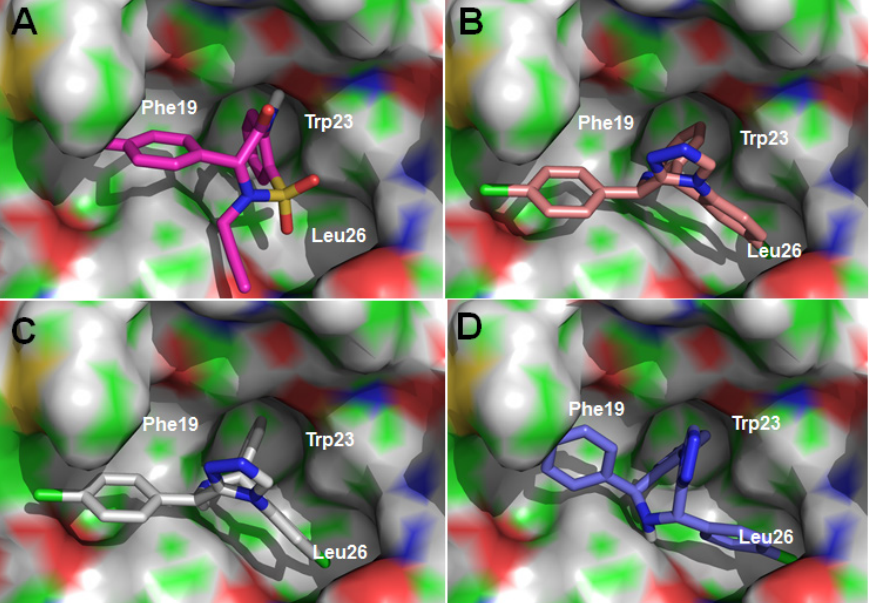
Figure 2. Docking modes of the sulfamide and triazole benzodiazepines with MDM2: ( A ) compound 7c (R); ( B ) compound 16 (R); ( C ) compound 17 (R, R); ( D ) compound 17 ( S , S